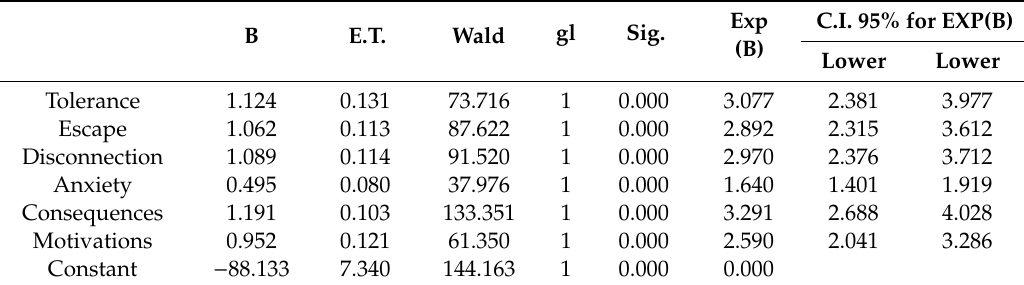
Table 5. Binary logistic regression of the self-perception of the problematic smartphone use a of Colombian university students with respect to the MPPUSA. B E.T. Wald gl